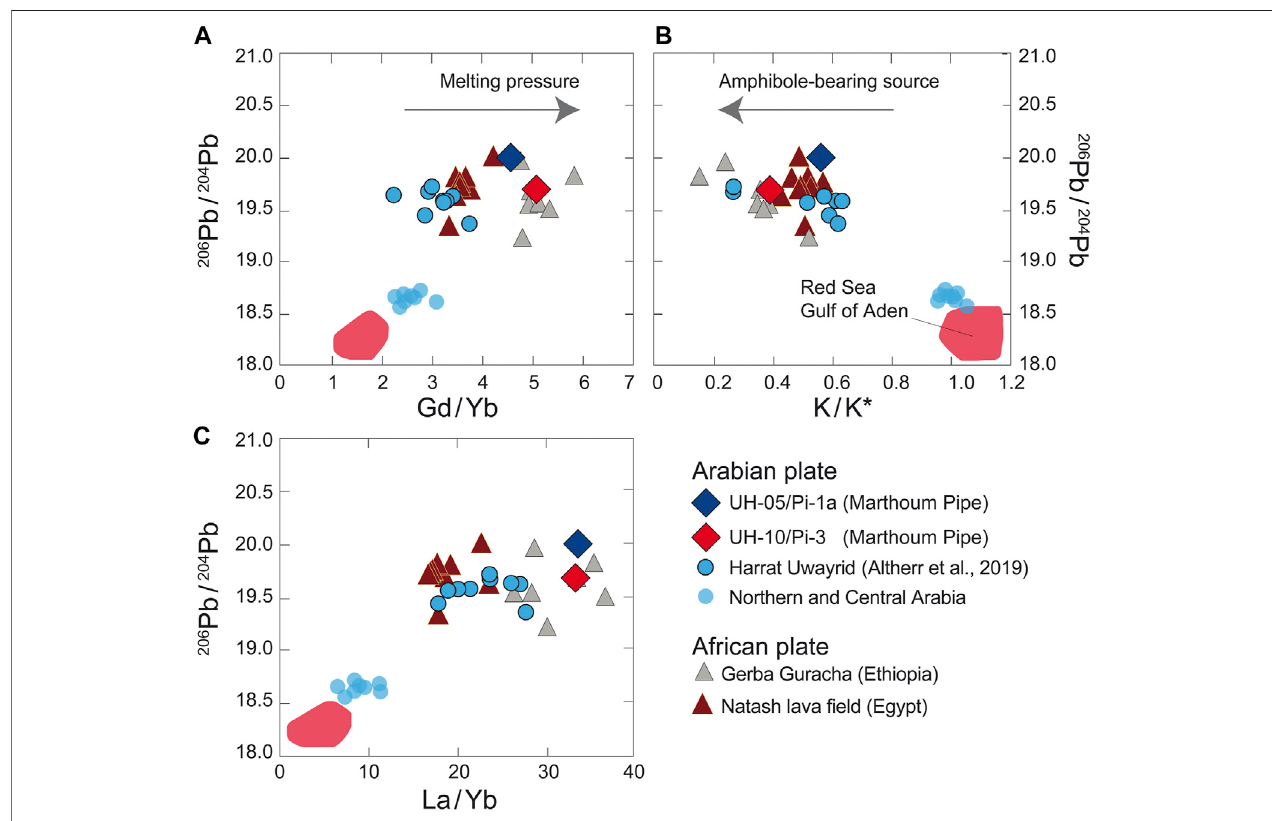
FIGURE11| Variationsofpresentday 206 Pb/ 204 PbversusGd/Yb (A) ,K/K* (cid:1) K N /[(Nb*La)] (B) andLa/Yb (C) inCenozoicalkalinelavasfromArabia,EastAfricaand MORB erupted in the Red Sea axial trough and Gulf of Aden. Symbols as in Figure 7 .